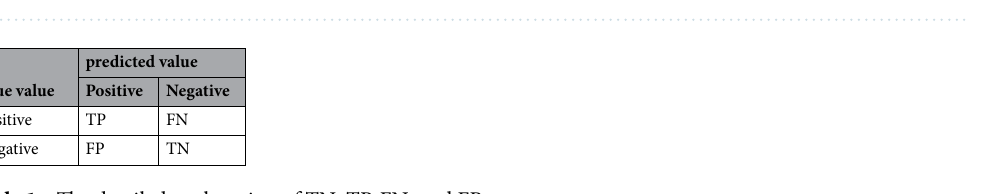
Table 1. The detailed explanation of TN, TP, FN, and